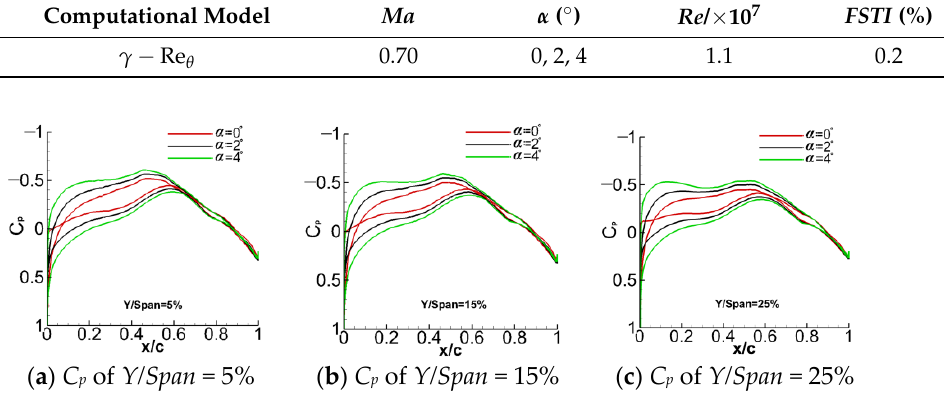
Figure 19. Comparison of C p curves of the central experiment wing with different α at various locations along the span.